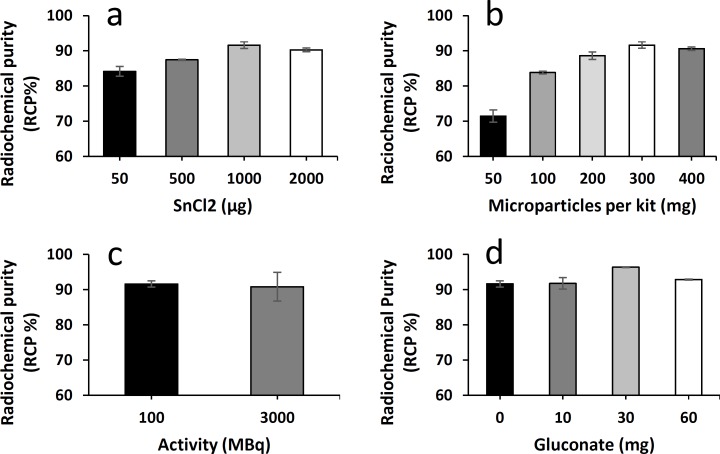
Influence on the RCP of several parameters during the 188Re radiolabeling of SBMP.(a) RCP of 300mg SBMP radiolabeled kits with varied amount of SnCl2. (b) RCP of 1mg SnCl2 radiolabeled kits with varied amount of SBMP. (c) RCP of 300mg SBMP, 1mg SnCl2 kits with varied amount of activity. (d) RCP of 300mg SBMP, 1mg SnCl2 kits with varied amount of gluconate.